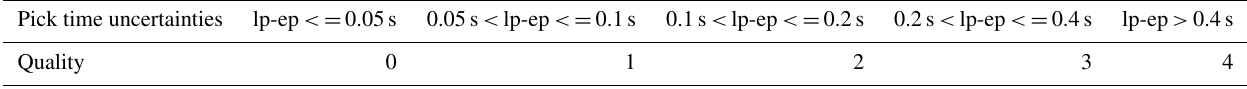
Table A1. Definition of the error quality relationship; lp-ep represents the time window in which the final pick is manually selected.